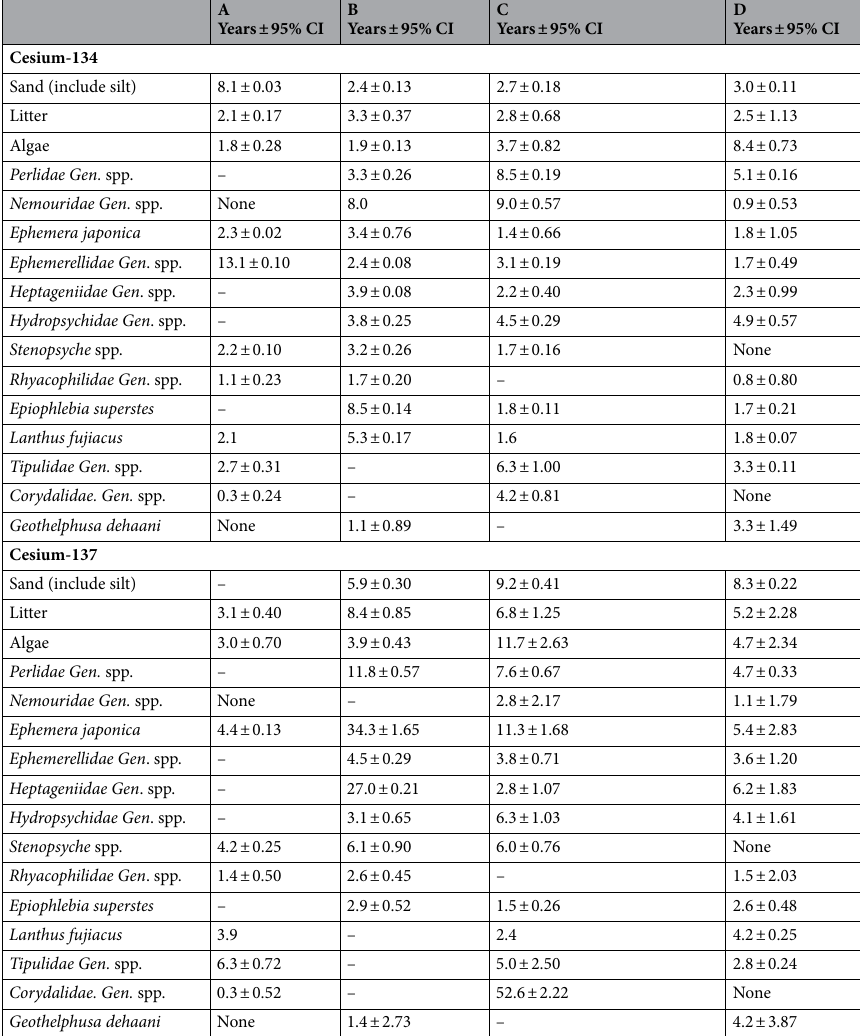
Table 3. Ecological half-life of 16 groups at sites A, B, C and D. CI: confidence interval; –: positive relation between the cesium-134 and cesium-137 and the year; none: no sample.